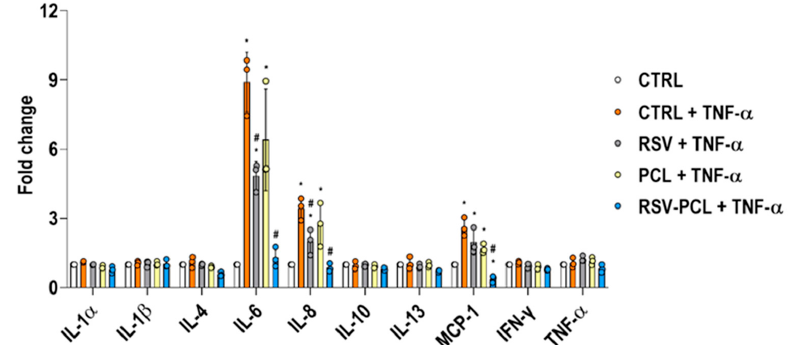
Figure 7. Effect of 0% RSV-PCL (PCL) and 10% RSV-PCL (RSV-PCL) electrosprayed microparticles on inflammatory cytokines release of human dermal fibroblasts. Multiplex ELISA quantification analysis showed that 10% RSV-PCL microparticles (100 μ g/mL) significantly ( p < 0.05) reduced secretion of IL-6, IL-8, and MCP-1 after 7 days of treatment. Media containing 5 μ M RSV were used as positive controls. The results are normalized to untreated control (CTRL) cells. * indicates a statistically significant difference to the CTRL group ( p < 0.05). # indicates statistically significant to CTRL + TNF- α group ( p < 0.05). Individual values are displayed as dots on bar charts. Error bars represent mean ± SD. Generalized linear models and bootstrap- t -tests. Immunocytochemistry (Figure 8A) and complementary relative fluorescence intensity (Figure 8B) analysis of the NF- κ B subunit p65 illustrated that the stimulation of fibroblasts with TNF- α induced significant ( p < 0.05) nuclear translocation of p65. However, treatment of TNF- α stimulated cells, either with RSV or 10% RSV-PCL microparticles, did not robustly prevent or reverse the nuclear translocation of the NF- κ B subunit p65, even though a minor effect was noted (RSV: p = 0.041; 10% RSV-PCL: p = 0.014).